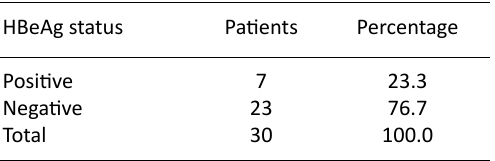
Table 2. HBeAg Status of Patients HBeAg status